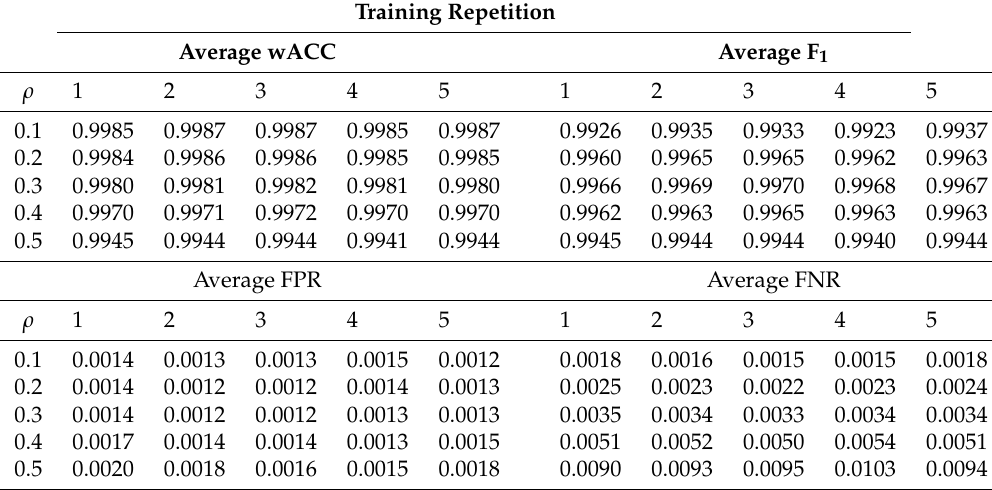
Table 2. Repeatability of the training on BSD500 dataset in terms of weighted accuracy (wACC), False Positive Rate (FPR), False Negative Rate (FNR) and F 1